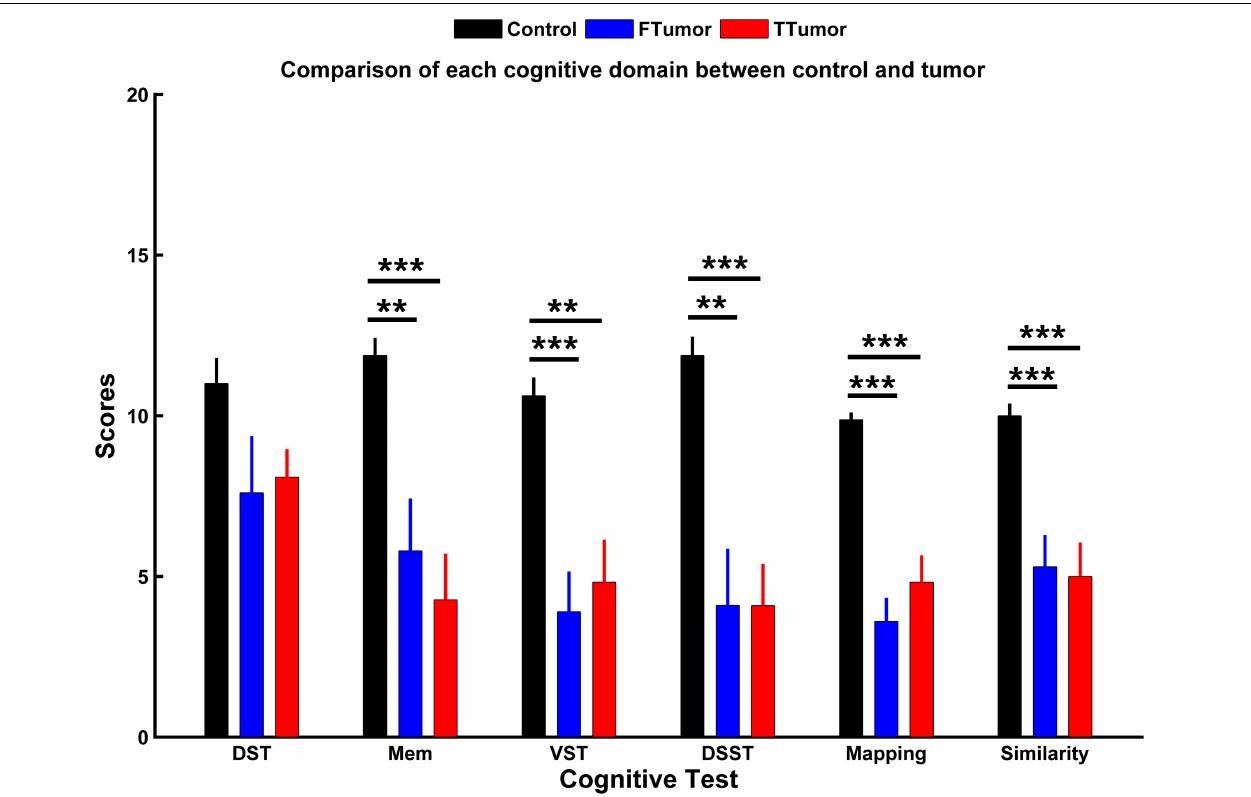
FIGURE 2 | Comparison of each cognitive domain between control subjects and patients with frontal and temporal tumors. FTumors, frontal tumors; TTumors, temporal tumors; DST, digit span test; Mem, memory test; VST, visuospatial test; DSST, Digital Symbol Substitution Test; mapping, picture completion test (this test is mainly performed to measure visual memory, visual recognition, and the ability to distinguish between the main characteristics and unimportant details); similarity, similarity test (this test is mainly performed to measure logical thinking ability, abstract thinking ability, and generalization ability). ** p < 0.01, *** p < 0.001.